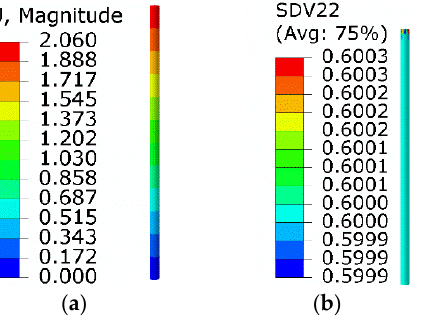
Figure 4. Results of step 1: ( a ) axial displacement; ( b ) the volume fraction of M t .